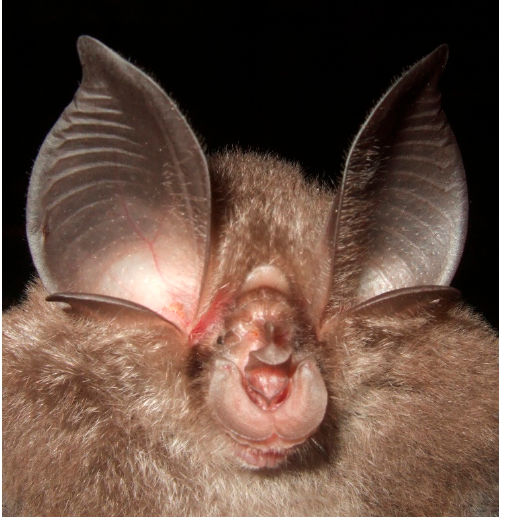
Figure 6. Rhinolophus siamensis , adult male. Photograph by Vu Dinh Thong.